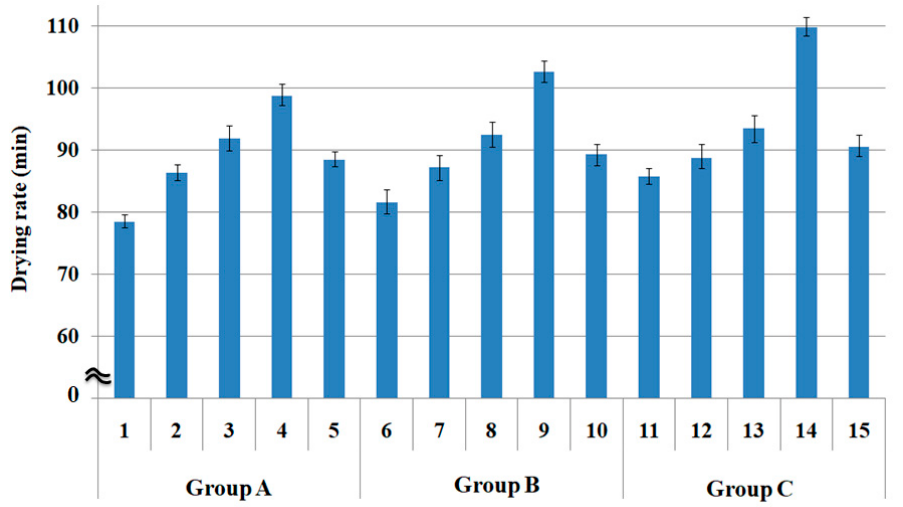
Figure 5. Drying rate at a steady state of the fabric specimens ( p < 0.05).